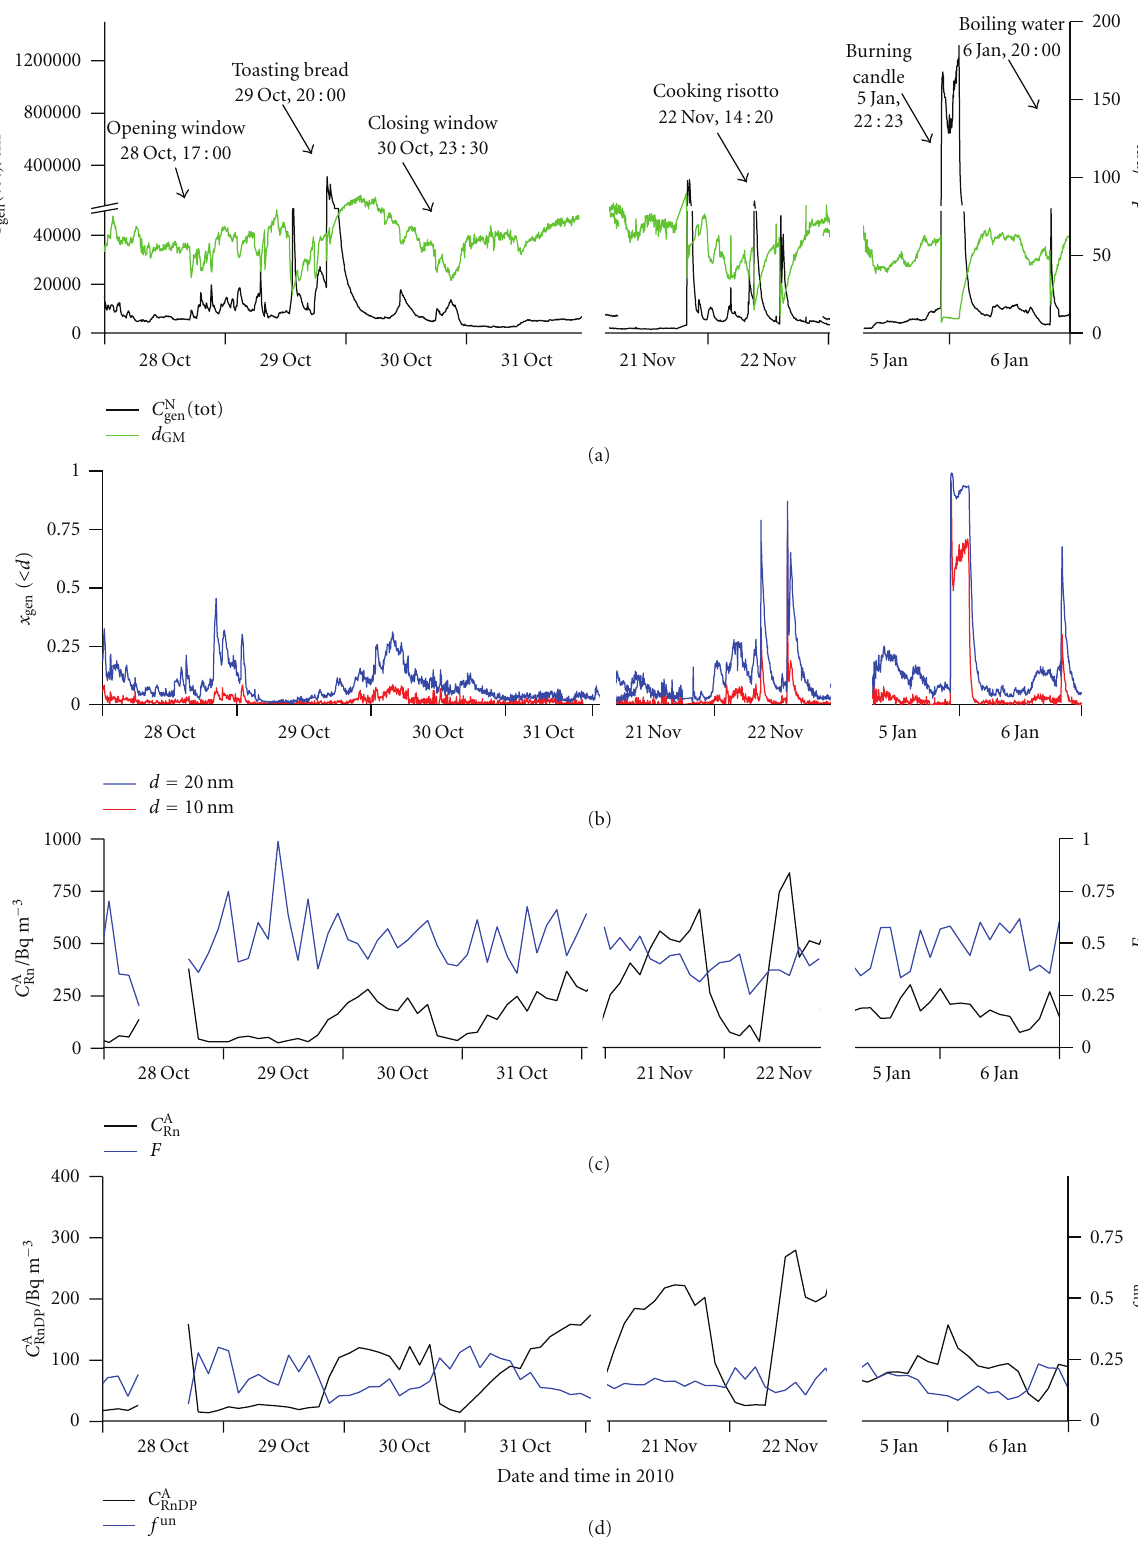
(tot)) and geometric mean values of their diameters gen